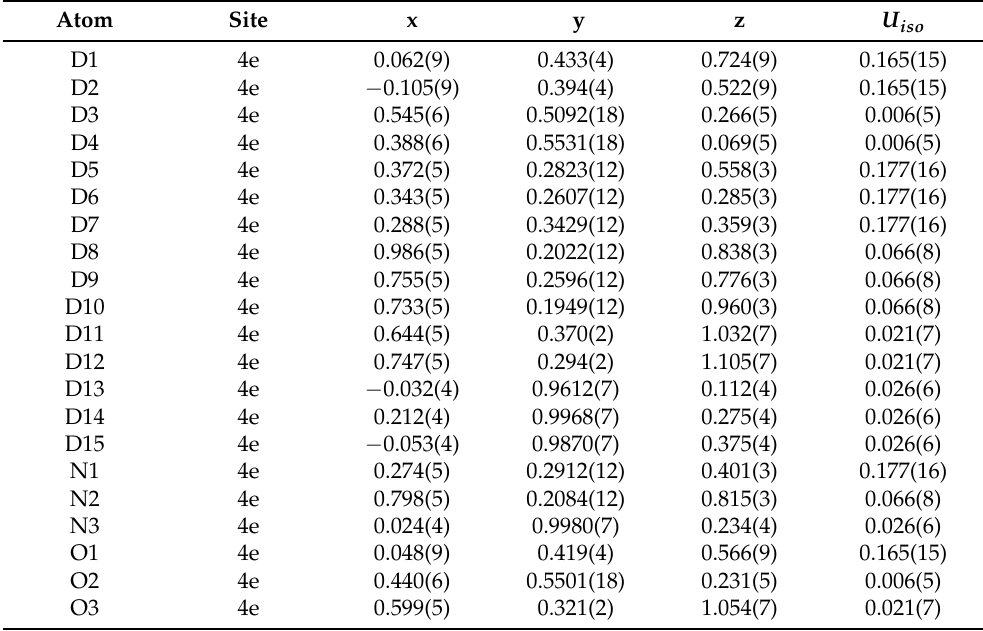
Table 1. Atom site, position and isotropic displacement parameters for AMH-IV in space group P2 1 / c (II); lattice parameters a = 5.487 ( 3 ) Å, b = 19.068 ( 4 ) Å, c = 5.989 ( 3 ) Å, and β = 99.537 ( 16 )